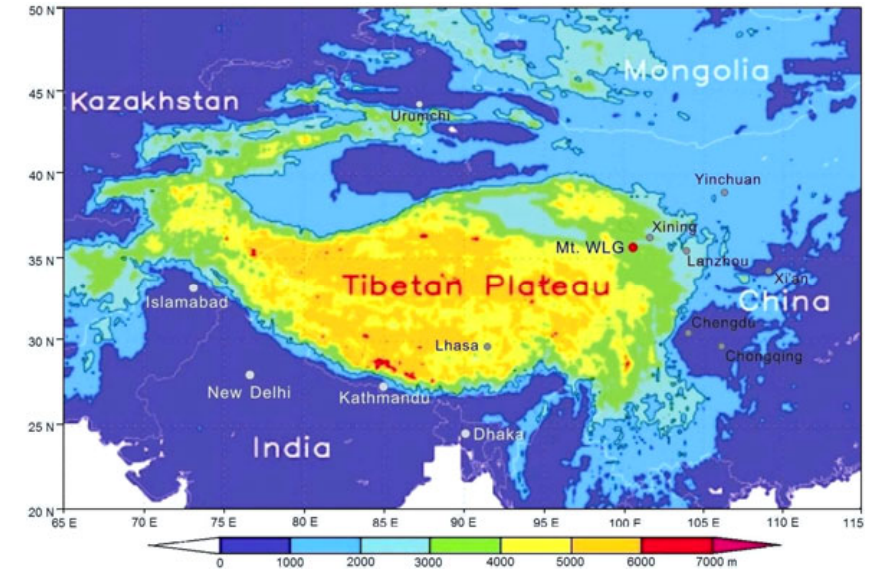
5 Fig. 1. Map showing the location of Mount Waliguan Observatory